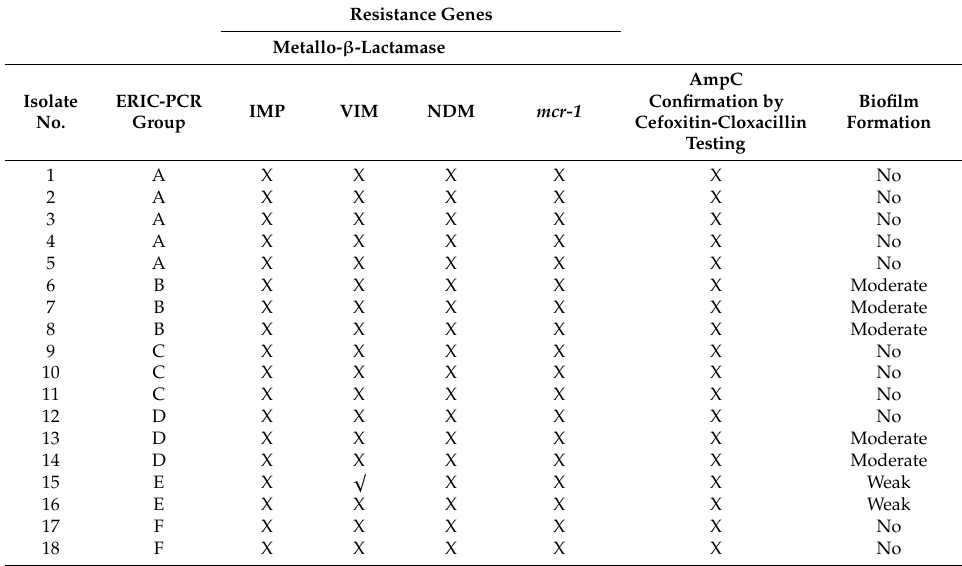
Table 4. The clonal relationship, presence of metallo- β -lactamase genes and mcr-1 , AmpC confirmation by cefoxitin-cloxacillin testing, and biofilm formation in colistin-resistant P. aeruginosa . Resistance